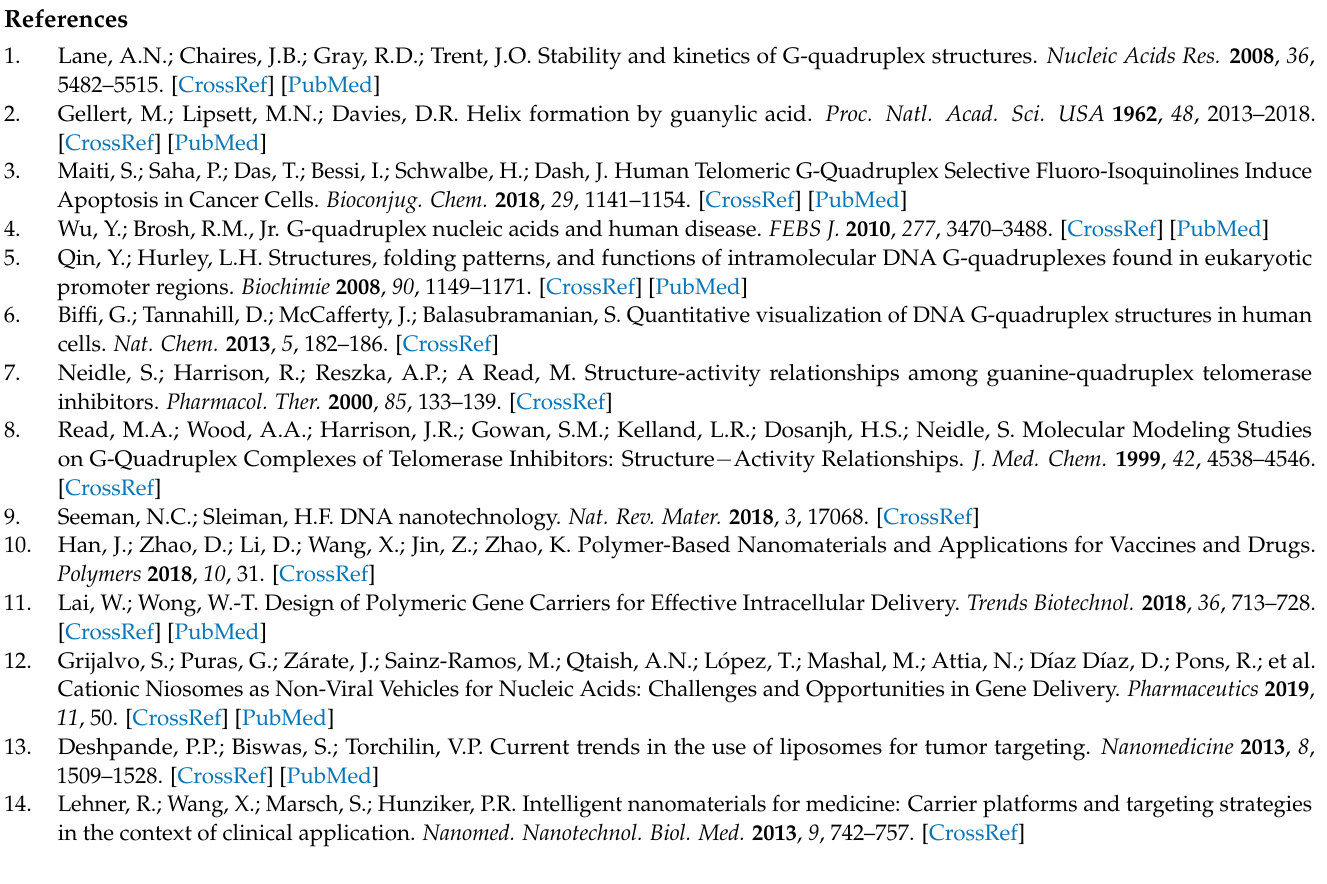
conjugates. Figure S2: ThT assay; Table S1: Affinity constants; Figure S3. Cytotoxicity analysis on HEK2983 cells; Figure S4: Flow cytometry analysis at 60 nM; Figure S5: Flow cytometry analysis at 300